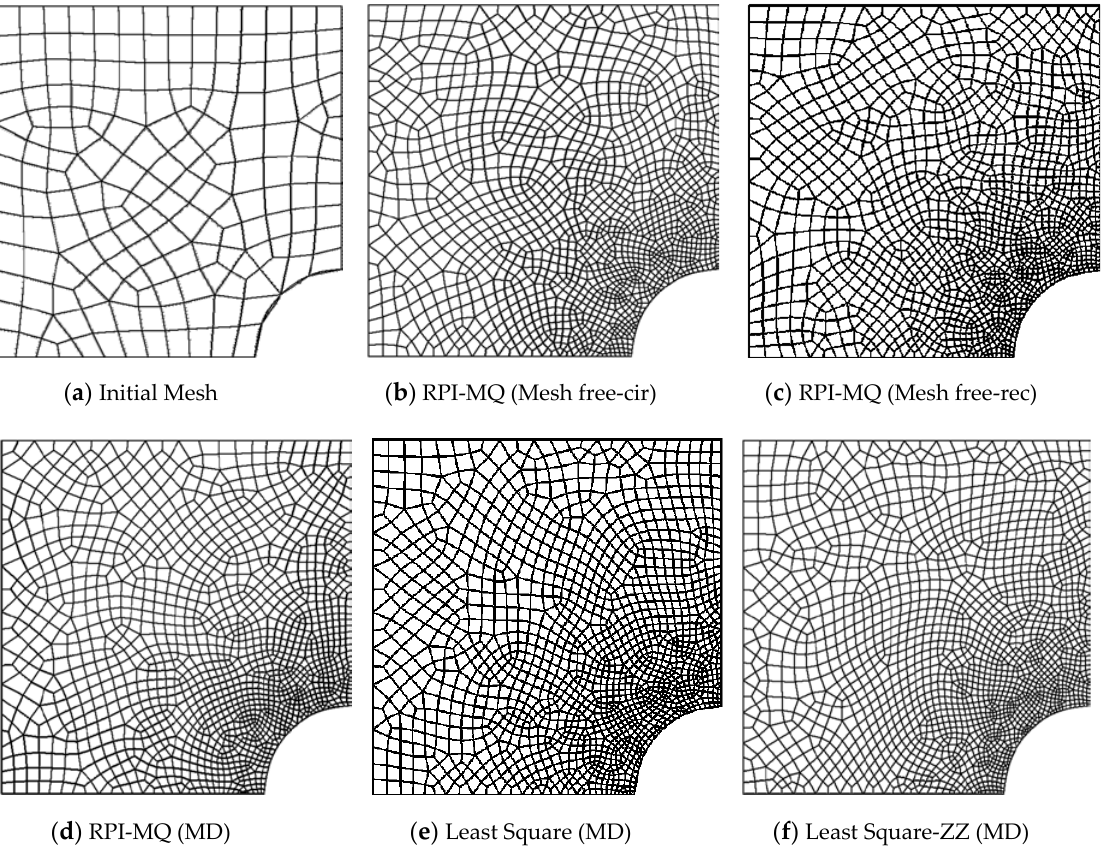
Figure 8. Adaptively improved mesh in elastic plate with opening using mesh free RPI, mesh dependent RPI and least square error recovery analysis (initial quadrilateral mesh elements = 179, 2% target error).